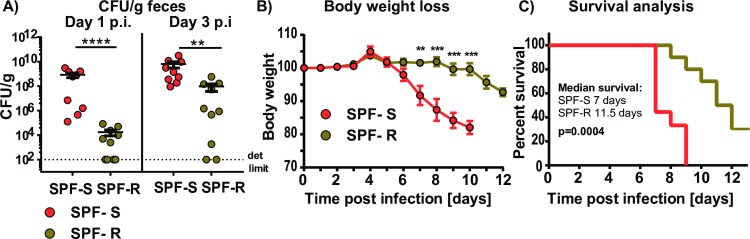
Variations in microbiota composition are correlated with lethal outcome of infections with a Shiga toxin-expressing C. rodentium strains.(A-C) SPF-S and SPF-R mice were infected orally with 108 CFU C. rodentium DBS 770 and fecal colonization, body weight loss and survival were determined. Dashed lines indicate the limit of detection. Results represent two independent experiments with n = 4–5 mice/group as mean ± SEM. P values indicated represent a nonparametric Kruskal-Wallis test *p<0.05, **p<0.01, ***p<0.001, ****p<0.0001.